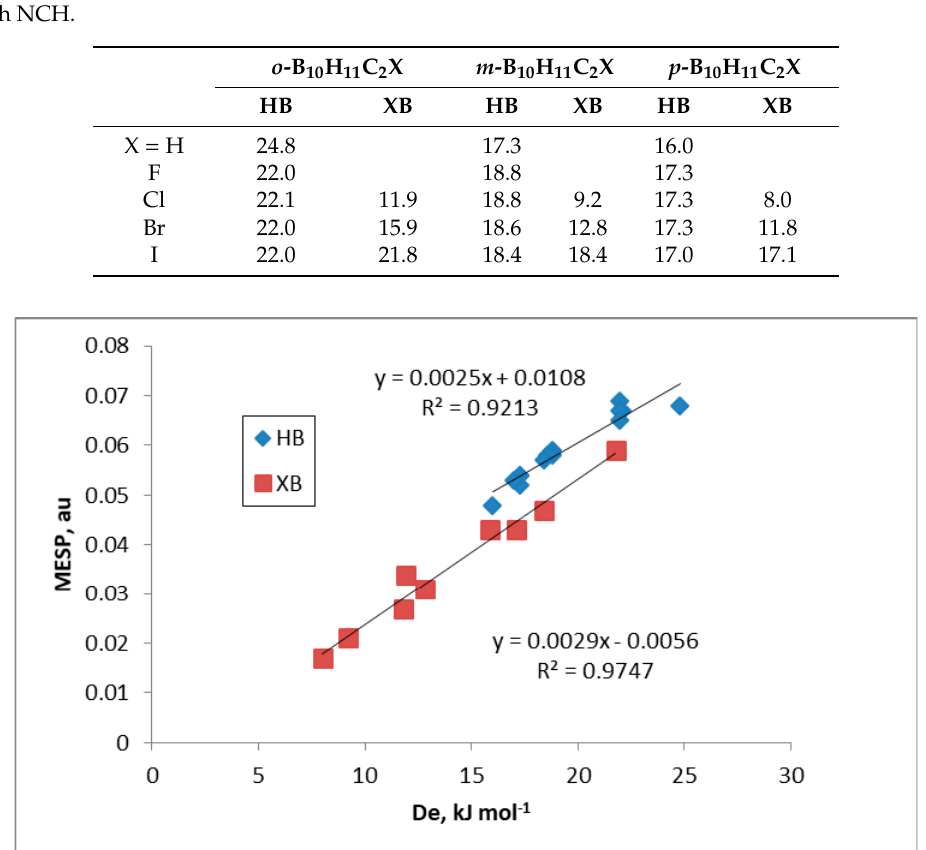
Figure 2. The MESP (au) vs. De (kJ·mol − 1 ) in the hydrogen bond (HB) and halogen bond (XB) complexes. Table 2. Dissociation energy (kJ·mol − 1 ) for the hydrogen- (HB) and halogen-bonded (XB) complexes with NCH.